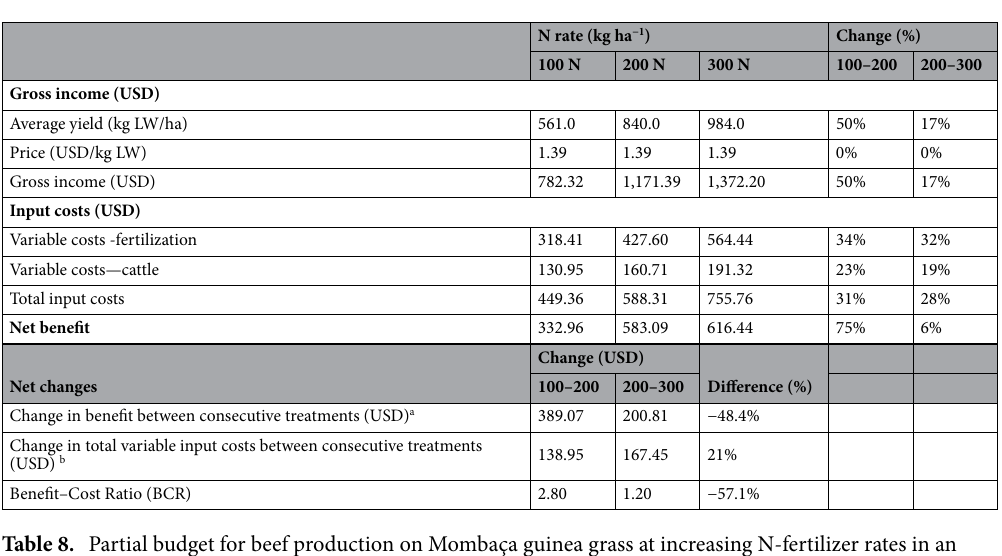
Table 8. Partial budget for beef production on Mombaça guinea grass at increasing N-fertilizer rates in an alternative scenario (25% reduction in yield). 1 Currency exchange 1.0 BRL = 0.258 USD (2018/2019 average, based on 26 observations over this period. Source: https:// www. xe. com/ curre ncyco nvert er/). a Change in